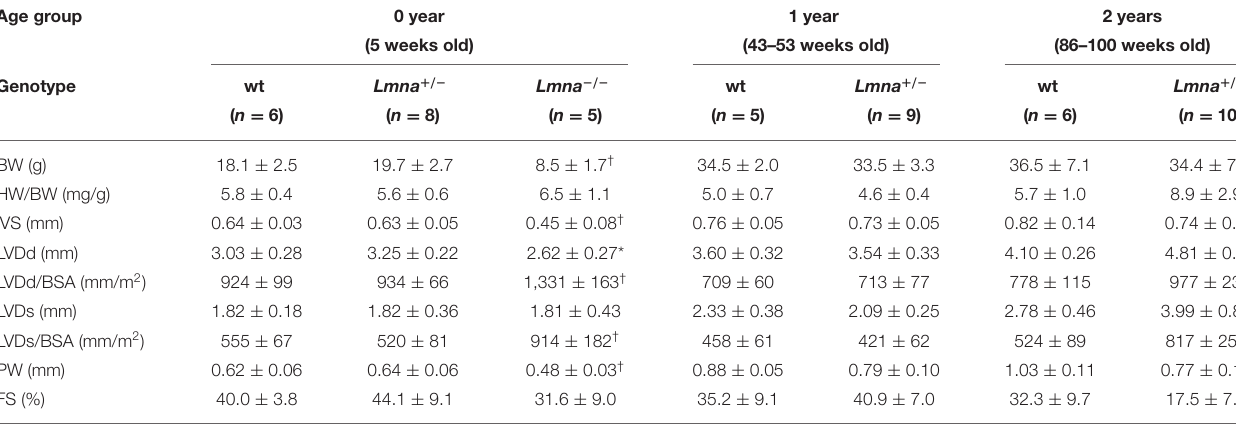
TABLE 1 | Physical and echocardiographic characteristics of the mice used in this study. Age group